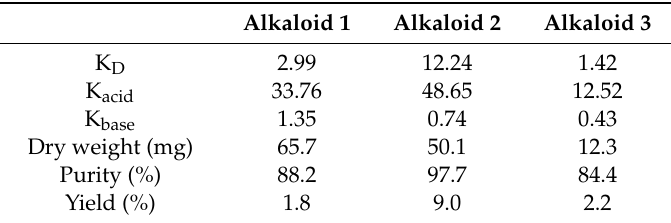
Table 4. Partition coe ffi cients, purity and yields of compounds 1–3 using pH-zone-refinement CPC with the solvent system MtBE / ACN / W, 6 mM formic acid and 16 mM